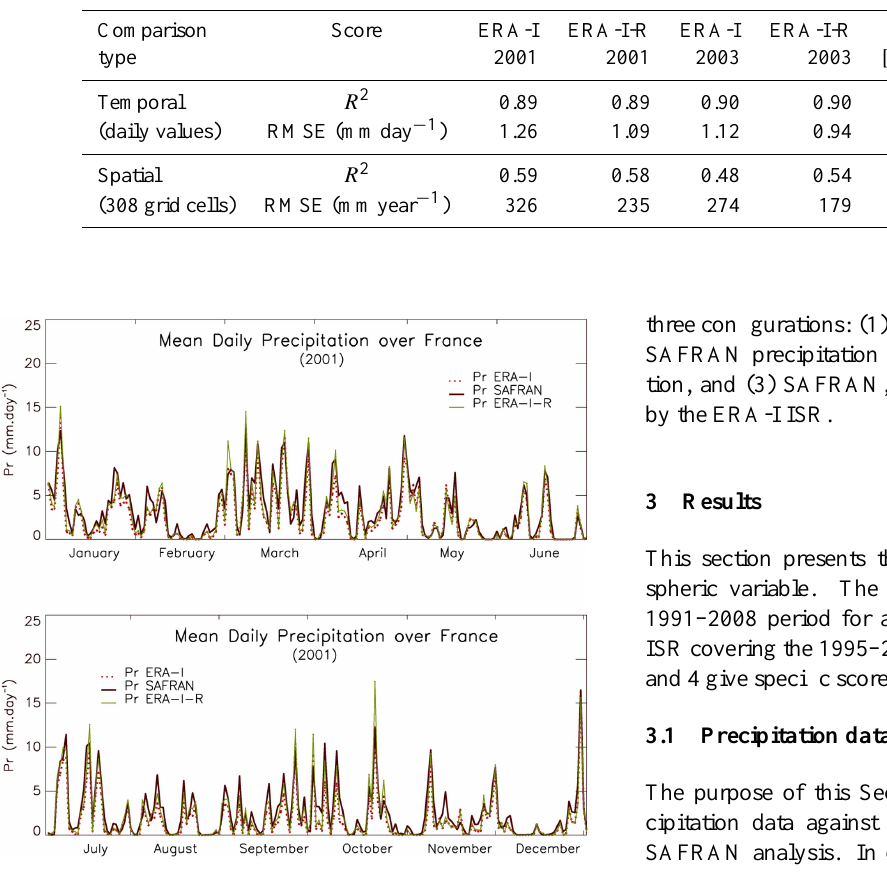
Fig. 2. Mean daily precipitation over France for SAFRAN, ERA-I and ERA-I-R: from (top) January to June 2001, and from (bottom) July to December